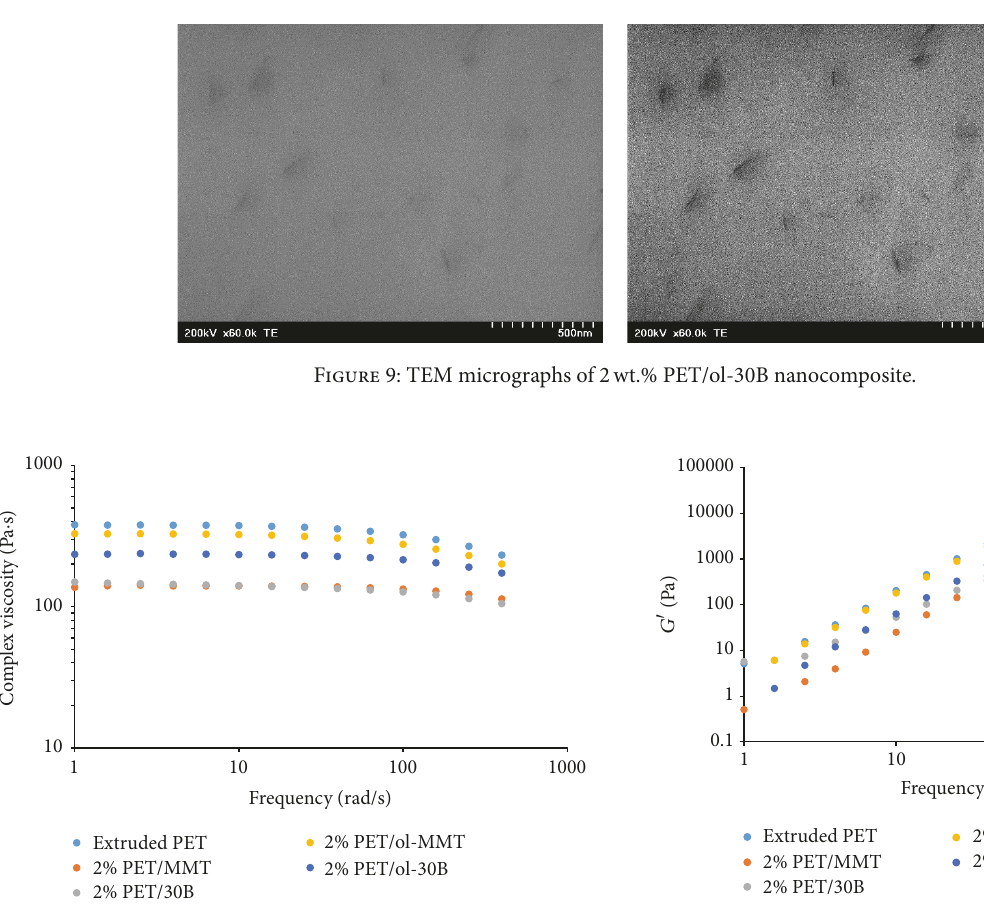
Figure 10: Melt viscosity of PET and nanocomposites. Figure 11: Storage modulus of PET and